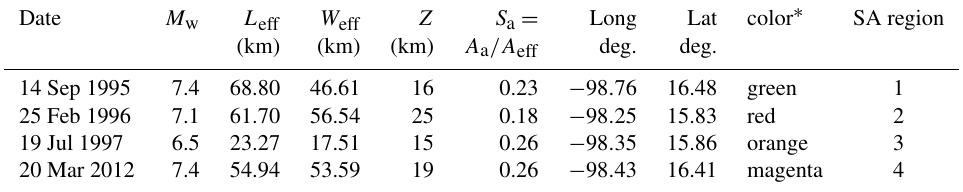
Table 1. Data of four large earthquakes occurred in SUB3 and reported by Rodríguez-Pérez et al. (2018). Specifically, the date of occurrence, moment magnitude M w , effective length L eff , width W eff of the area following the methodology in Mai and Beroza (2000), asperity area A a , and the epicentral coordinates “Long” and “Lat”.